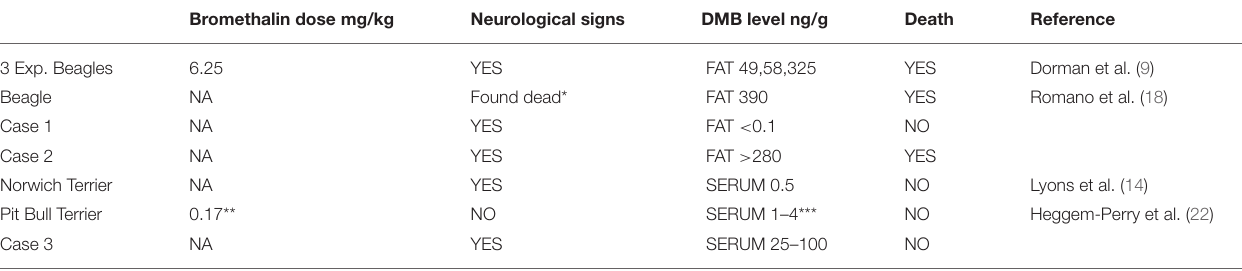
TABLE 1 | Reported desmethylbromethalin tissue levels and clinical outcomes in